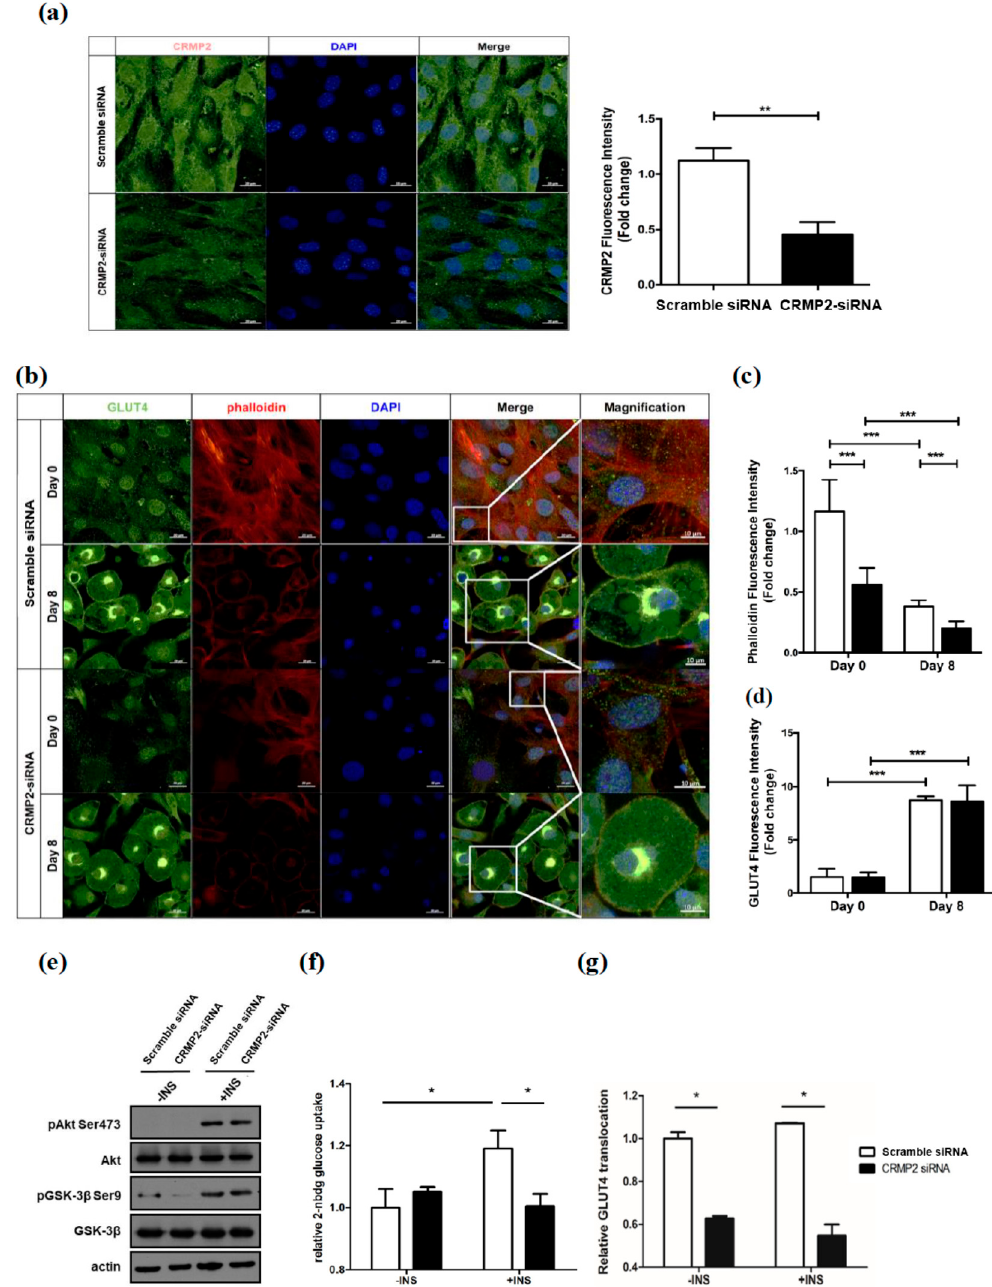
Figure 6. E ff ects of CRMP2 knockdown on cytoskeleton and glucose uptake. Cells were transfected with CRMP2-specific siRNA (CRMP2-siRNA cells) or control siRNA (scramble siRNA) on day -2, then subjected to di ff erentiation. CRMP2 ( a ), GLUT4 and phalloidin-positive actin filaments ( b – d ) were detected and quantified in transfects on day 0 / 8 as described. The scale bars represented 20 µ m in regular images and 10 µ m in Magnification images, respectively. Data were presented as means ± SEM of about 50 cells in each group and analyzed by one-tailed unpaired Student t -test. Insulin-stimulated signaling molecules pAkt Ser 473 and pGSK-3 β Ser 9 ( e ), 2-NBDG uptake ( f ), and GLUT4 translocation ( g ) were measured as described. The data were presented as the mean ± SEM, and statistically analyzed by two-tailed unpaired Student t -test ( n = 3). * p < 0.05, ** p < 0.01, *** p < 0.005.